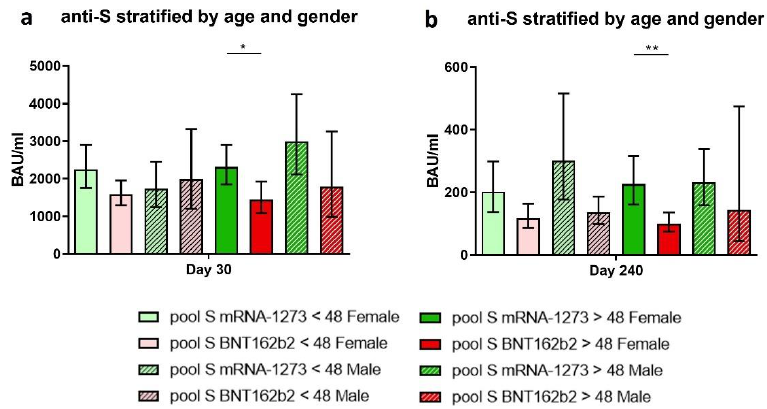
Figure 4. Anti-S IgG at days 30 and 240 stratified by age and gender. The estimated means and confidence intervals were calculated by a multiple linear regression model stratified by age and gender. Bonferroni’s correction was used. Bars represent the mean and confidence intervals for anti-S IgG BAU/mL at days 30 ( a ) and 240 ( b ). Each graph represents volunteers vaccinated with mRNA-1273: women < 48 years (light green), women > 48 years (dark green), men < 48 years (striped light green), and men > 48 years (striped dark green). Volunteers vaccinated with BNT162b2: women < 48 years (light red), women > 48 years (dark red), men < 48 years (striped light red), and men > 48 years (striped dark red). * p -value < 0.05. ** p -value < 0.01. Regarding the production of cytokines after whole-blood stimulation with the SARS- CoV-2-derived spike peptide pool, we observed several significant differences on day 30 and day 240 post-vaccination between stratified groups. Globally, almost all stratified groups showed higher levels of specific anti-S cellular responses when individuals were vaccinated with mRNA-1273 than those vaccinated with BNT162b2. Early after vaccina- tion (day 30), the IFN- γ, IL -2, and IL-4 responses were significantly higher in women younger than 48 years old (Figure 5a, p -value = 0.042; Figure 5c, p -value < 0.001, and Figure